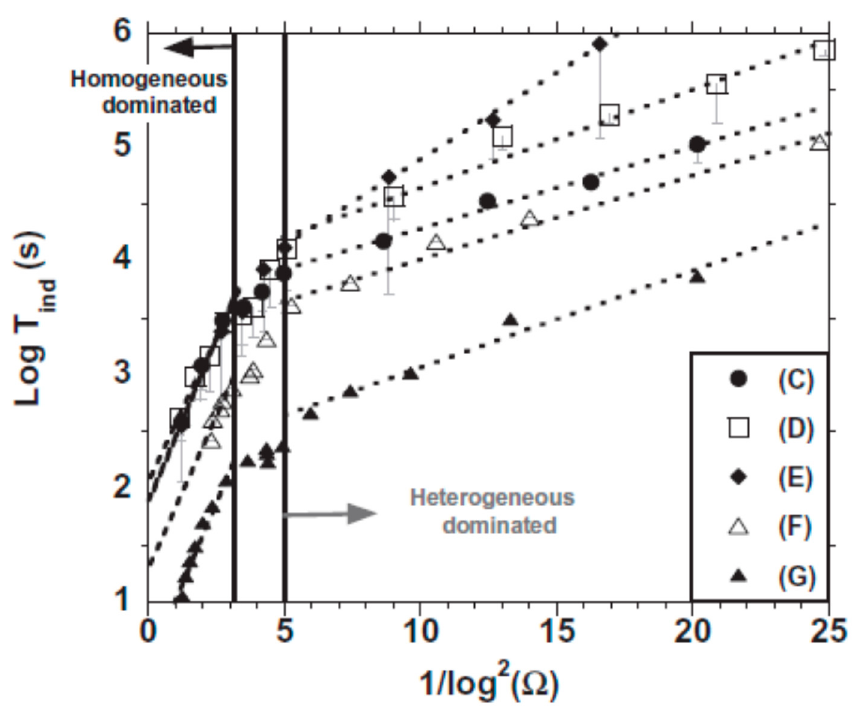
Figure 17. A plot of the measured Log T ind vs. 1/log 2 ( Ω ) for different saline compositions. The Ω gypsum at which the slope changes is interpreted, based on the CNT as the oversaturation at which the mechanism of nucleation changes between homogeneous and heterogeneous. Series C–G represent different mixtures between Dead Sea brine and seawater. Reprinted From Reznik et al. [79] with permission from Elsevier.